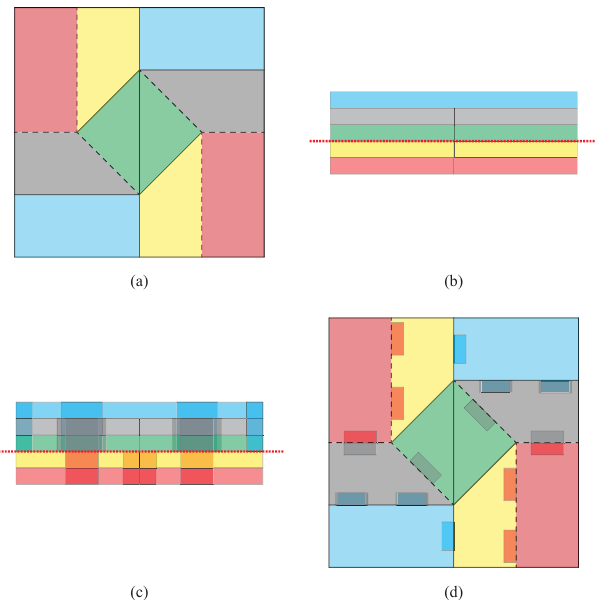
Figure 5. A schematic of the pattern used in the design of the ki- netic sculpture. (a) The square twist crease pattern. (b) A side view of the stacked panels and joint plane (represented by the red line). (c) The panel stack with offsets. (d) The unfolded panels including the offsets for the OPT model.